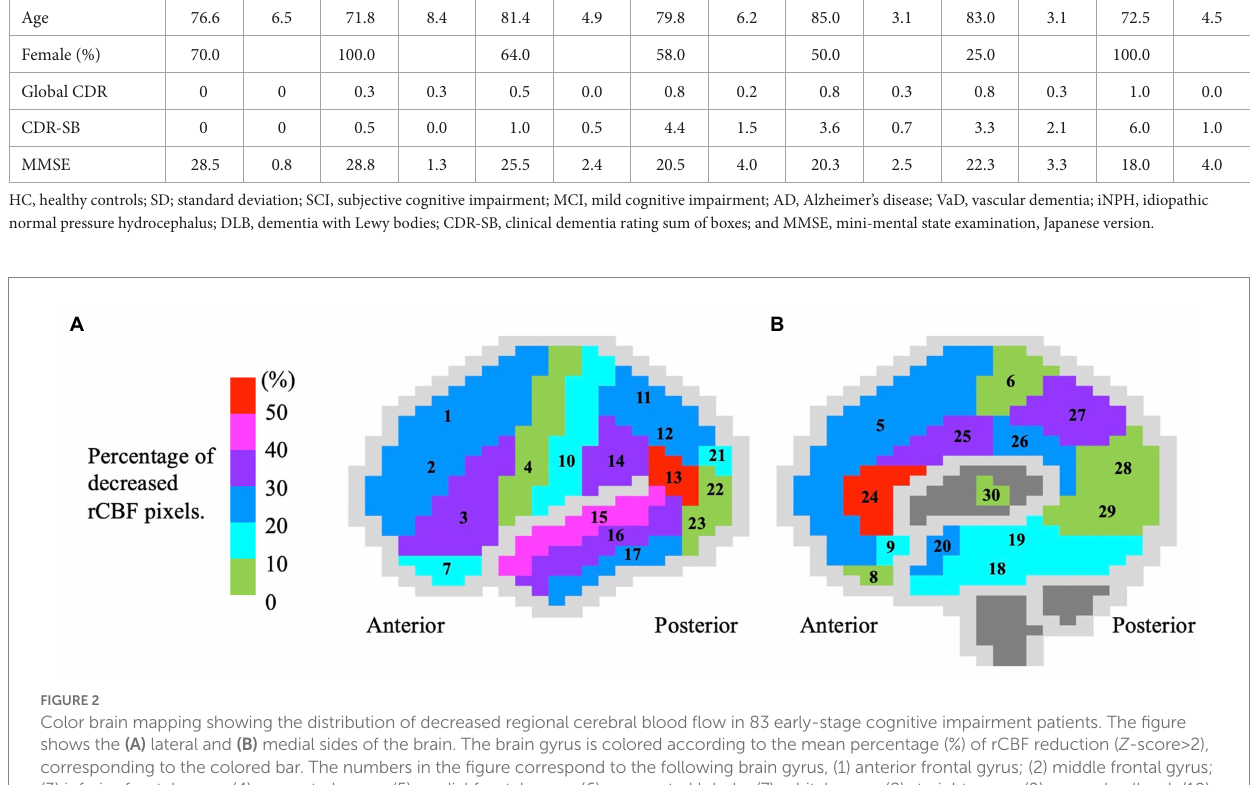
TABLE 2 Clinical diagnosis of patients with early-stage cognitive impairment. Clinical diagnosis (n)